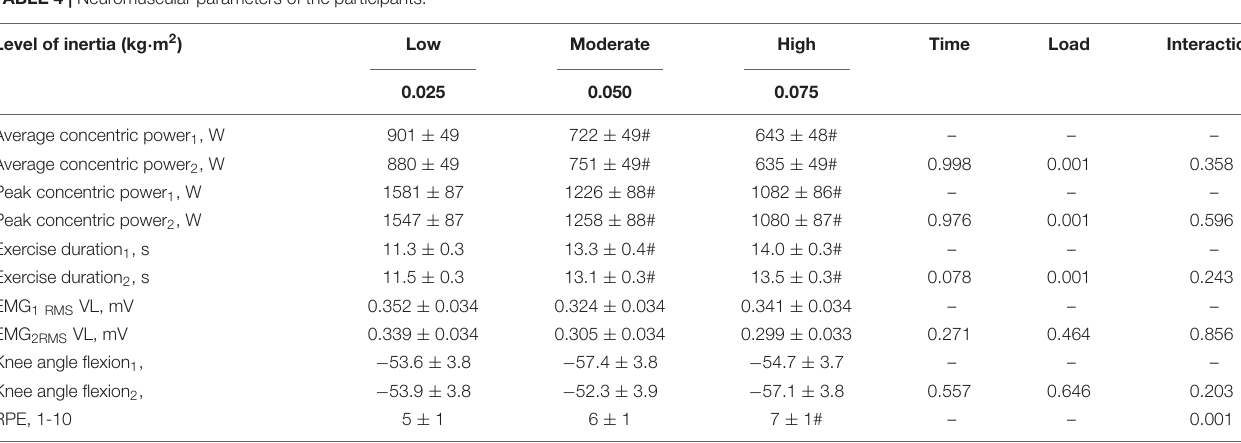
FIGURE 3 | Correlation analysis between the changes in the mean arterial pressure (both average black circles and maximum gray triangles) versus the age of the participants per load ( Low A set 0.025; Moderate B 0.05; and High C 0.075 kg m 2 , moments of inertia ). TABLE 4 | Neuromuscular parameters of the